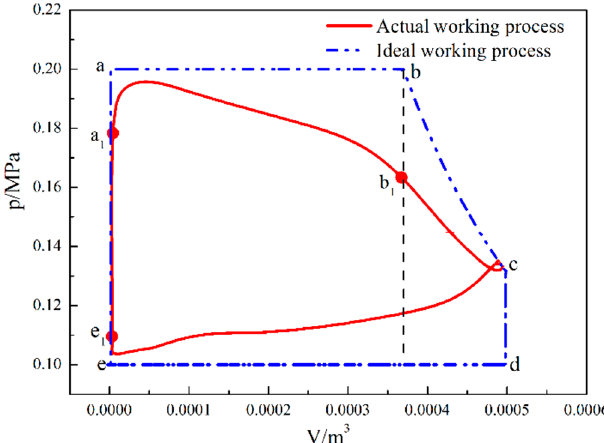
Figure 11. p – V indicator diagram of the FPE A.